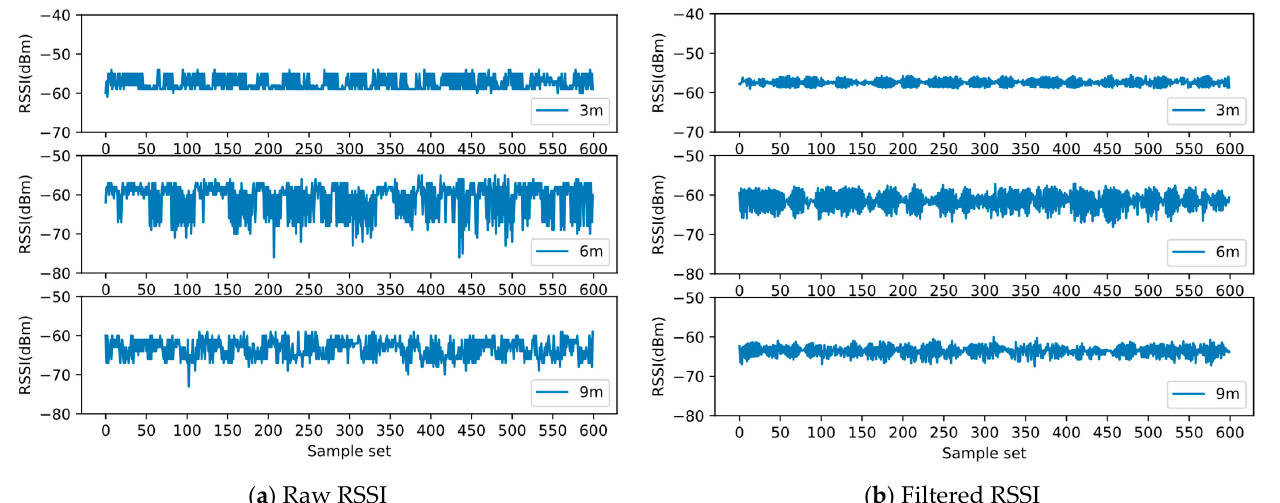
Figure 4. Raw and filtered received signal strength indication (RSSI) of Bluetooth Low Energy (BLE) at 3, 6, and 9 m.